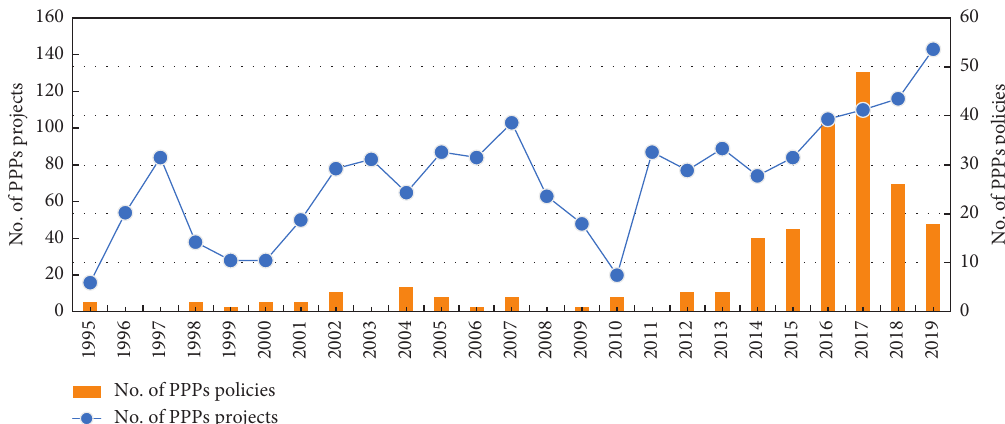
Figure 2: Number of PPPs policies and projects from 1995 to